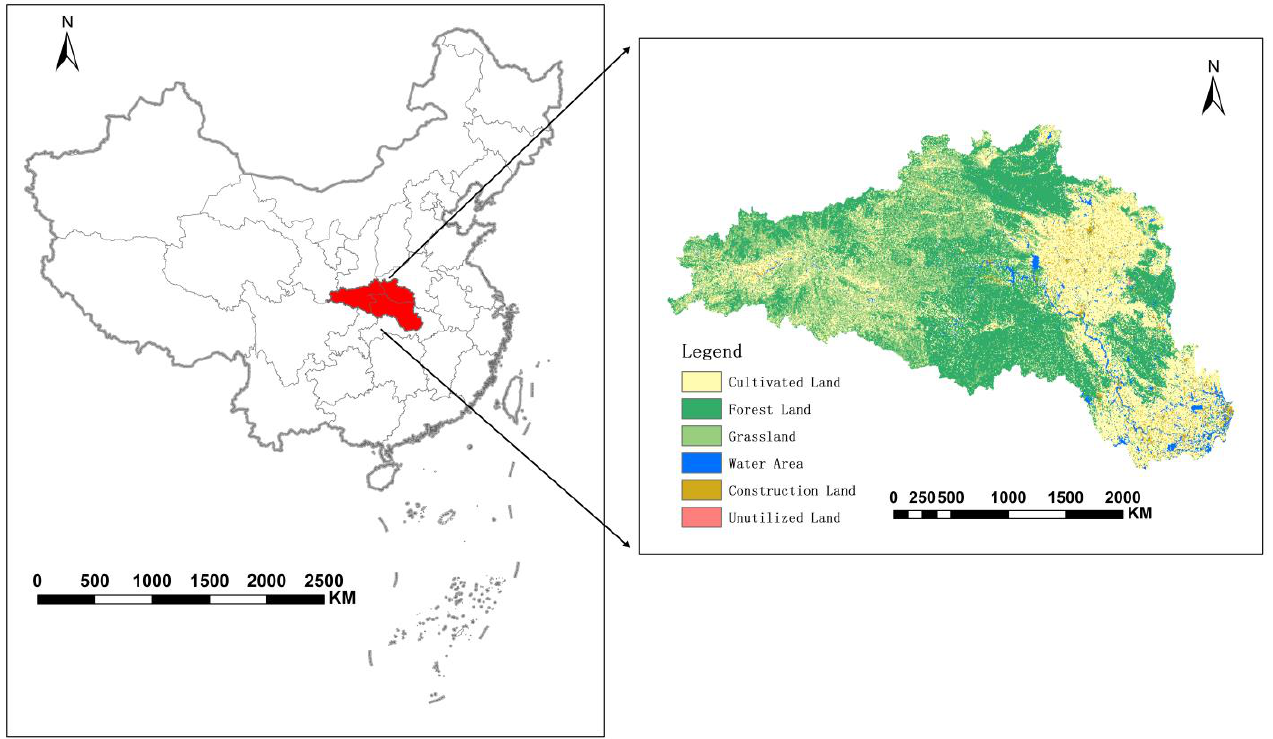
Figure 1. Overview of the Hanjiang Ecological Economic Zone.